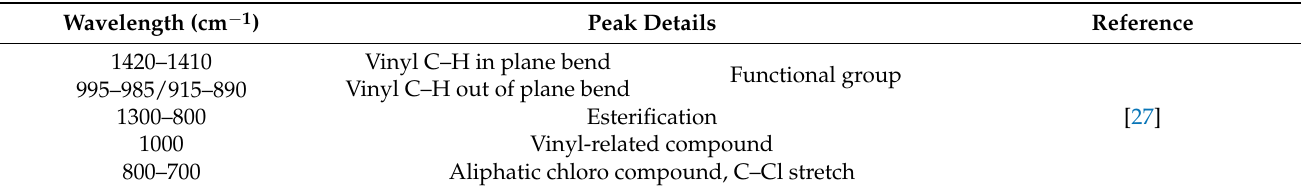
Table 6. Summary of important FTIR peaks in water retardant (T3)-treated jute